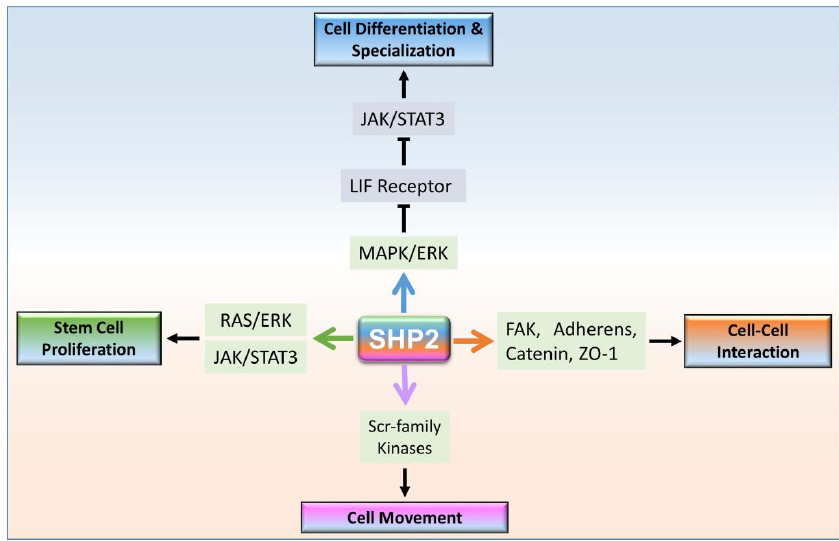
Figure 1. The role of SHP2 dependent signaling in the four essential basic processes of multicellular organism development. SHP2 promotes cell differentiation and specialization, stem cell proliferation, cellular interaction, and movement.